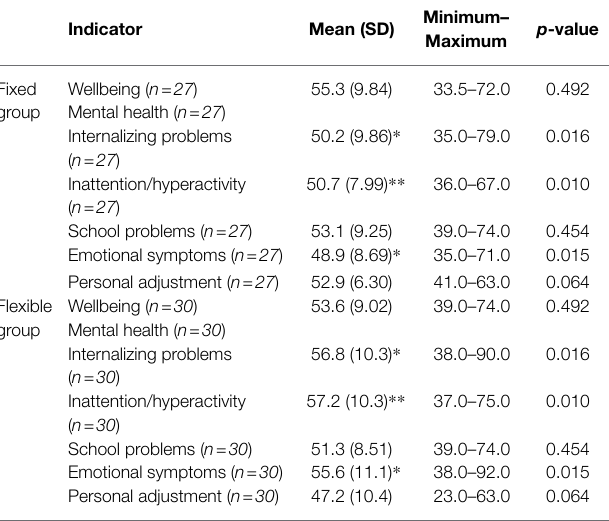
TABLE 7 | Mental health indicator results by group (fixed and flexible) for girls.